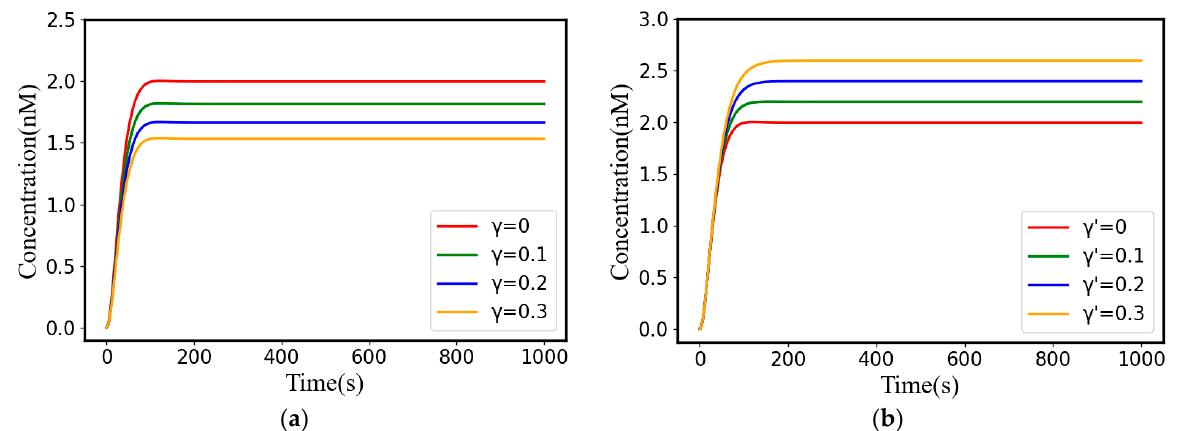
Figure 13. Leak reactions lead to errors in calculation results: ( a ) leak in the initial specie A ; ( b ) leak in the initial specie B .